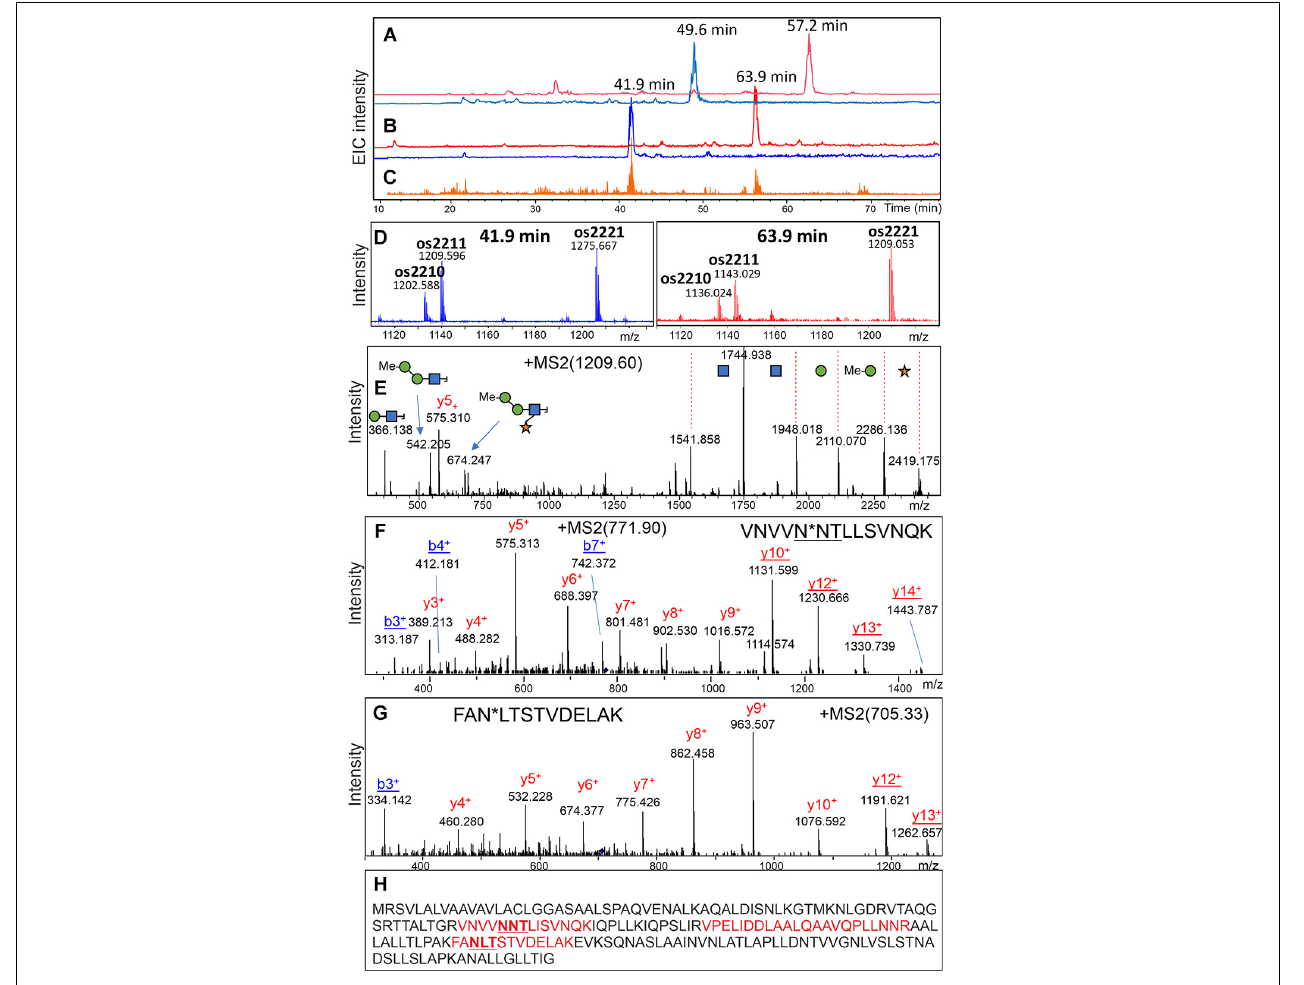
FIGURE 7 | Discovery of a glycopeptide in a “Raa” glyco-type sample. A search for glycopeptides was conducted in a HILIC-enriched fraction of tryptic peptides of product “Raa” C-76 by using the XIC for m/z = 366.1 (C) . MS XICs for m/z = 1,276.12 and 1,209.57 Th are shown in panel (B) with the respective MS sum spectra in panel (D) . The pattern of glycoforms resembled that of the free glycans ( Figure 1 ). The fragment spectrum for the peak with 1,209.59 Th confirms its glycopeptide nature (E) . Upon deglycosylation, the respective peptides could be found (A) , and their MSMS spectra allowed de novo sequencing (F,G) . A list of experimental and calculated masses is provided as Supplementary Table 3 . Sequence of the hypothetical protein with found peptides highlighted in red (H) . The MS/MS spectrum of the nonglycopeptide is shown in Supplementary Figure 9